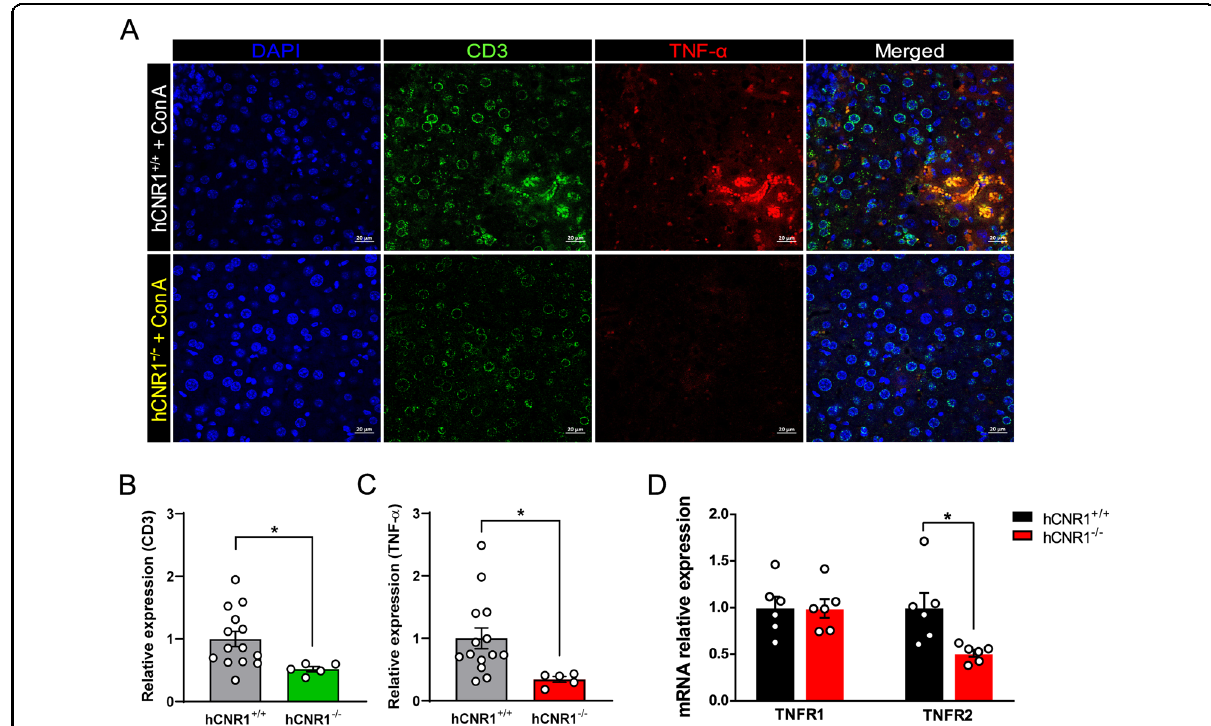
Fig. 5 Nulli fi cation of hepatic CB1R attenuates Con A-induced liver damage via cell membrane-bound TNF- α . A – C Liver samples without permeabilization were fi xed and sectioned, and immunostained for CD3, TNF- α , and DAPI (×40). Relative quanti fi cations of immuno fl uorescence stained tissues ( B , C ). D TNFR1 and TNFR2 mRNA expression levels. Results were expressed as mean ± S.E.M. (* p ≤ 0.05, ** p ≤ 0.01, and *** p ≤